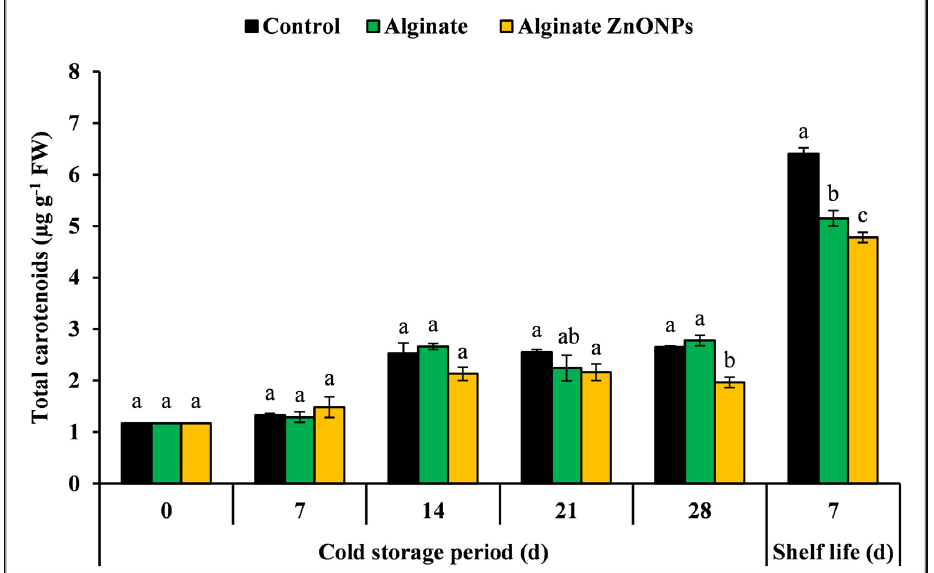
Figure 14. Effect of Alg–ZnO NPs on total carotenoids of “Kiett” mango fruits during cold storage and shelf life; vertical bars represent the standard error (SE). Bars marked with the same letter in each sampling date are not significantly different with 95% confidence according to Duncan’s multiple range test.